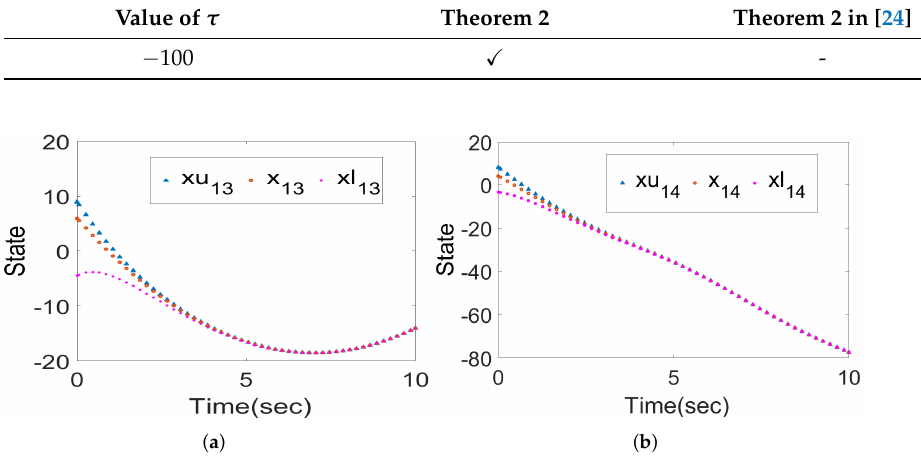
Figure 1. Evolutions of velocity of original system and DIO at the first joint ( a ) and second joint ( b ) of first manipulator.